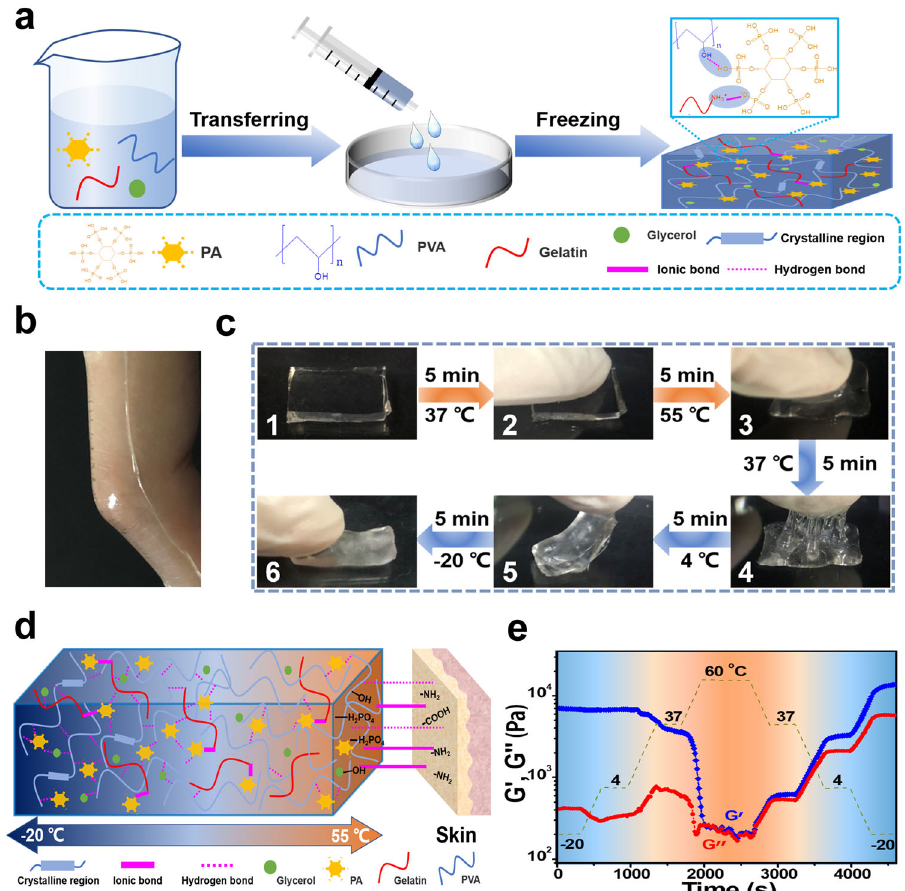
Fig. 1 Schematic illustration of the mechanism of PPG hydrogel. a Schematic illustration of the preparation about PPG hydrogel. b Photograph of the PPG hydrogel adhering to knuckles. c Photographs of the PPG hydrogel treated with different temperatures. d Schematic illustration of the mechanism about the controllable adhesion of the PPG hydrogel to skin. e Rheological properties of the PPG hydrogel at different